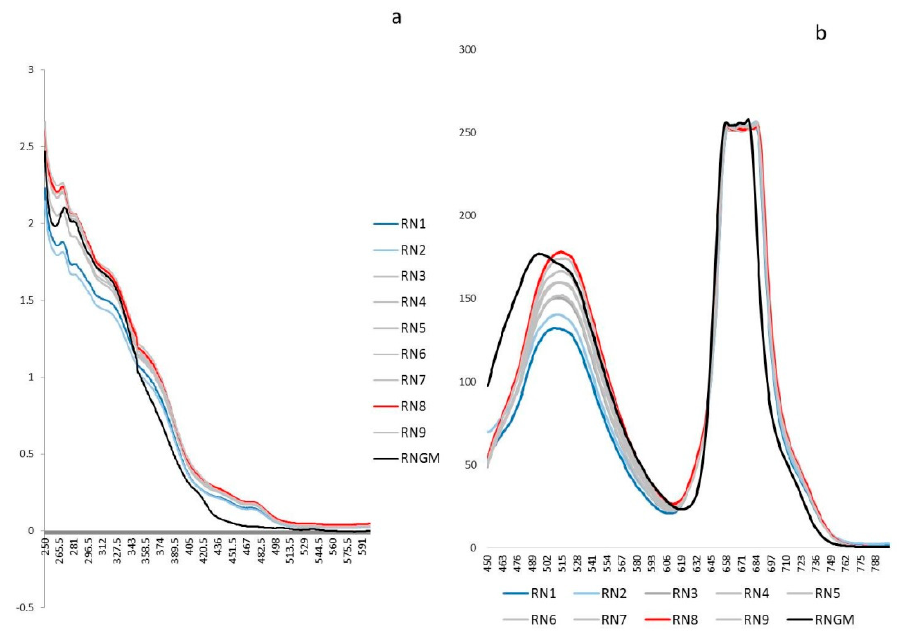
Figure 1. Untargeted spectroscopic fingerprints of the R. nigrum bud (RNB) phytocomplex: ( a ) The UV-Vis averaged spectra (250–600 nm) of the nine experiments selected by the DoE and the corresponding R. nigrum glyceric macerate (RNGM) tested at the same dilution (1:20 in the extraction solvent); ( b ) The 2D Fluorescence averaged spectral emissions (450–800 nm) of the nine experiments selected by the DoE and the corresponding RNGM tested at the same dilution (1:20 in the extraction solvent).